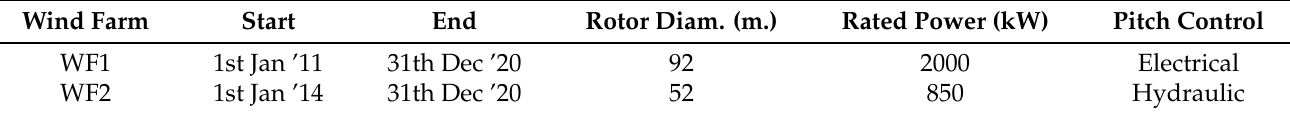
Table 1. The available data sets and the test